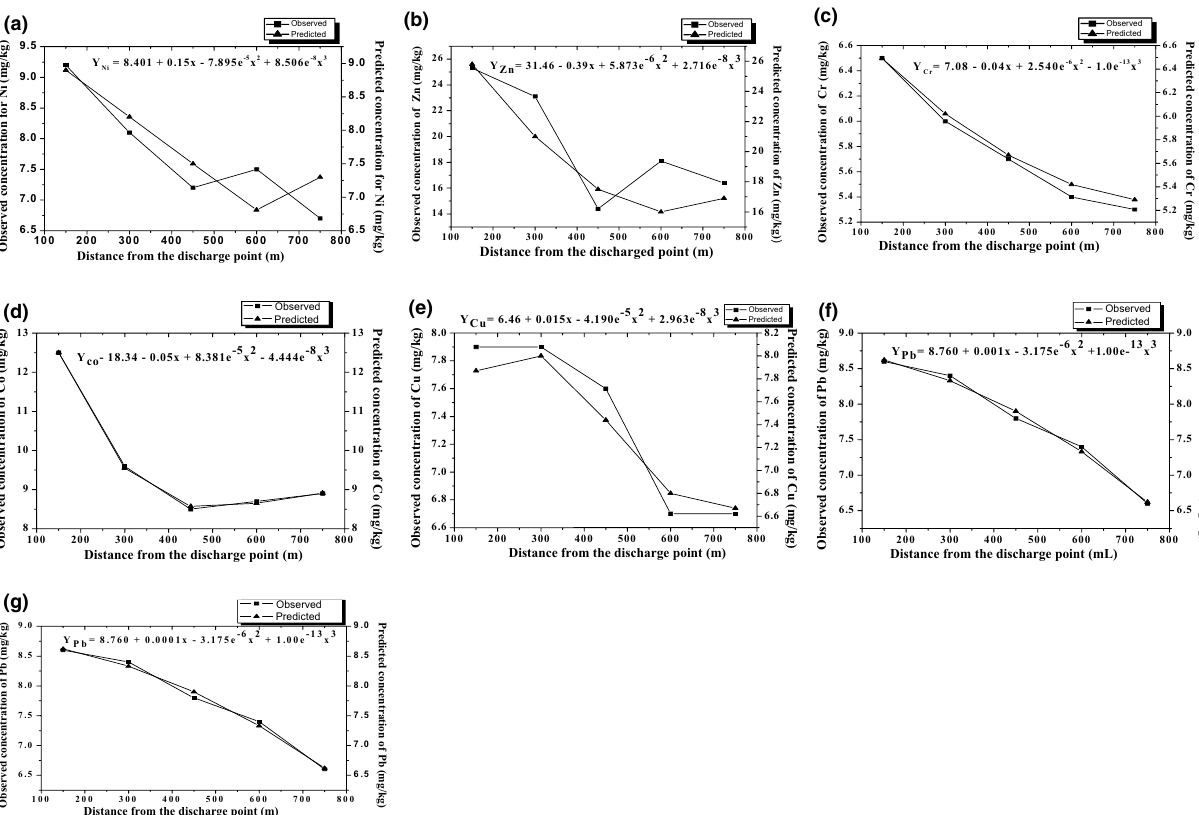
Fig. 4 Observed and predicted distribution patterns of Ni, Zn, Cr, Co, Cu, Cd and Pb as given as a – g,